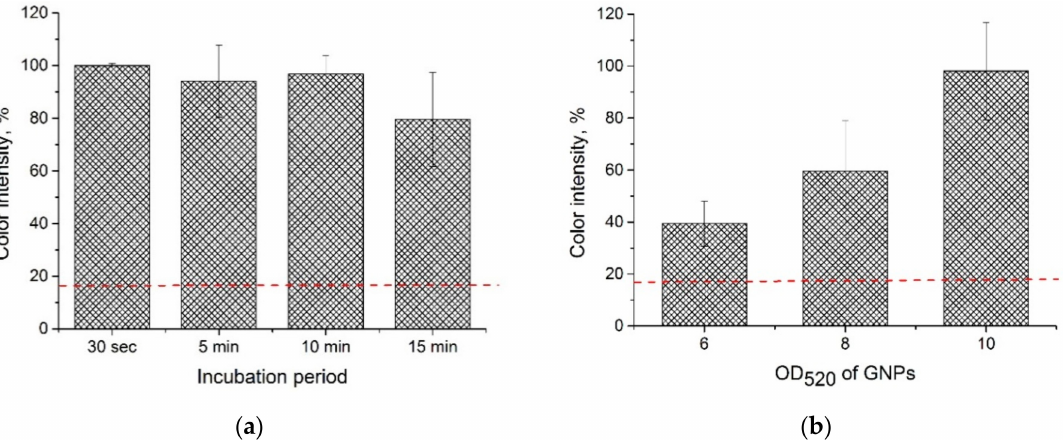
Figure 6. LFIA ( a ) with the addition of GNP conjugates in buffer solution and varied incubation time, ( b ) with GNP conjugates adsorbed on a conjugate pad and varied conjugate concentration. The PVY N concentration in all of the test strips was 1 µ g · mL − 1 . The red dashed line corresponds to the average percentage of color intensity in test strips with a conjugate pad and OD 520 = 4 (conventional